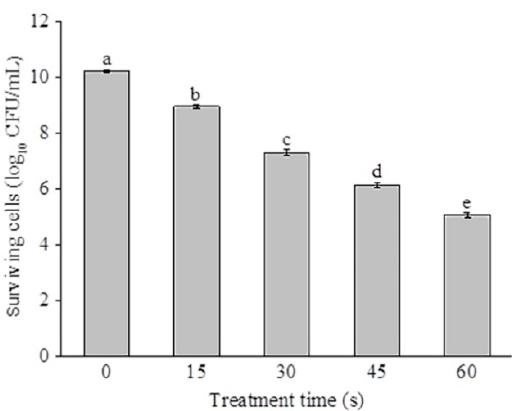
Figure 1. Inactivation effect of slightly acidic electrolyzed water (SAEW) against Pseudomonas deceptionensis CM2 cells. Bars labeled with different letters are significantly different from each other at p < 0.05 (least significant difference (LSD) test).